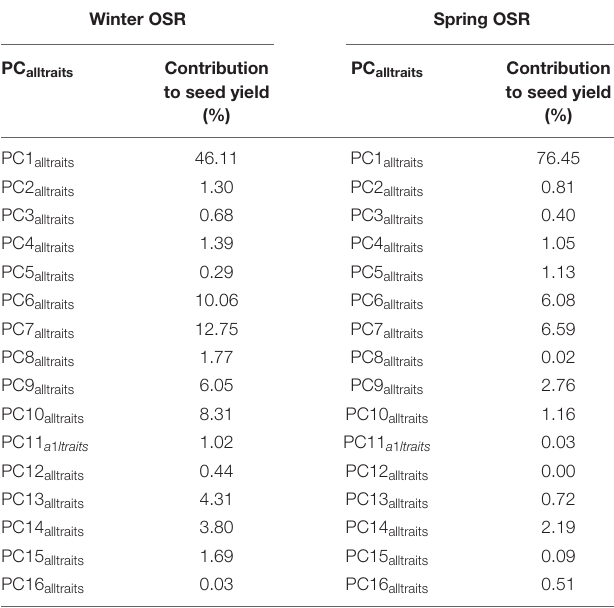
TABLE 3 | Principal component (PC) contribution to seed yield as a percentage of total variation explained from all PCs for Winter OSR and Spring OSR [expressed as contribution to yield (%)] for alltraits (macro and microtraits together).